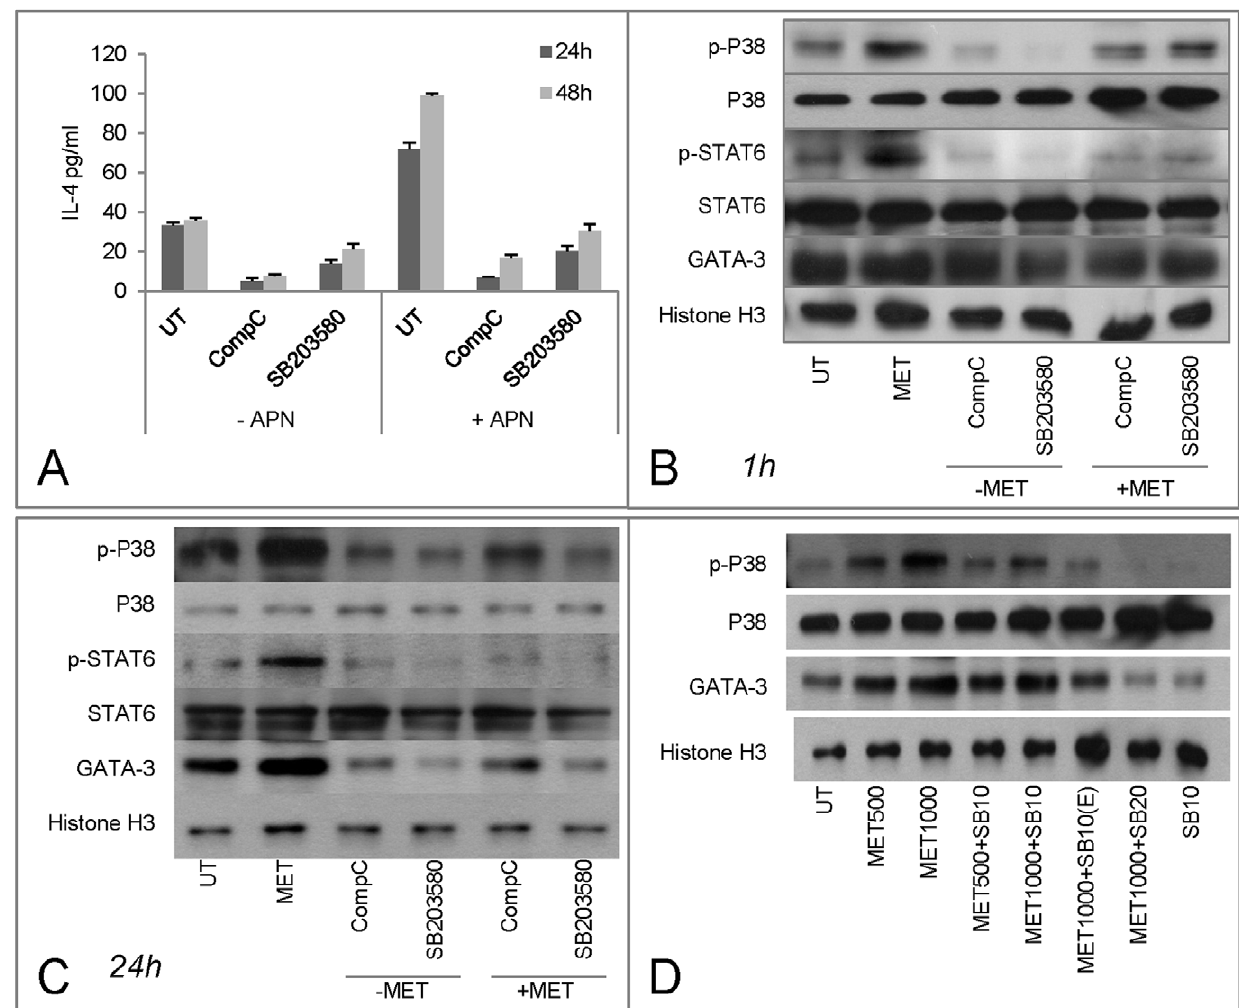
Figure 6. Functions of AMPK and p38 in IL-4 expression in response to Metformin (MET) treatment. A. EL-4 cells were cultured with APN (5 m M), Compound C (CompC, 10 m M) and SB203580 (10, 20 m M) for 1 h and 24/48 h and supernatants were collected for IL-4 detection (n=3). B and C. Nuclear proteins were obtained for intracellular signaling pathway molecules detection using Western blots. D. MET induced up-regulation of p- p38 was inhibited by increasing the dose of SB203580 or reducing that of MET or by pre-treating with SB203580 for 1 h (E) by Western